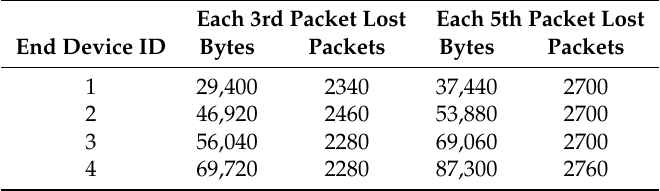
Table 4. Number of processed bytes in the nonbeacon ZigBee mode during a congestion. Each 3rd Packet Lost